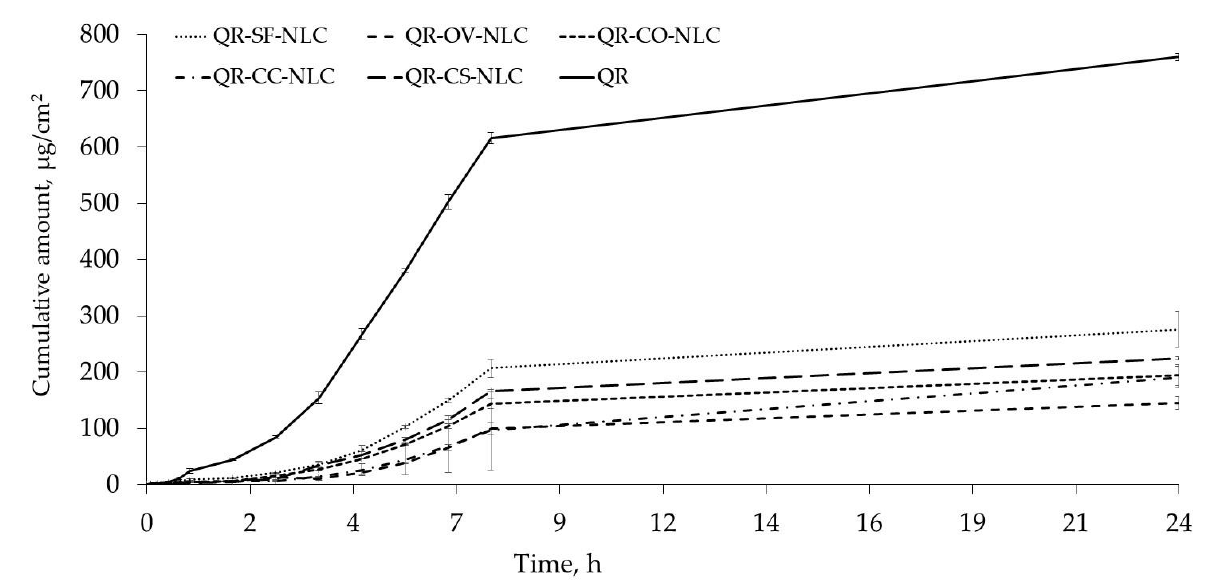
Figure 10. In vitro permeation profiles of QR-NPO-NLCs. Cumulative amounts released from NLCs in an RHE model. Plots were obtained from five experiments with each tested compound running under the same experimental conditions with three replicates. Error bars represent the mean ± SD value.